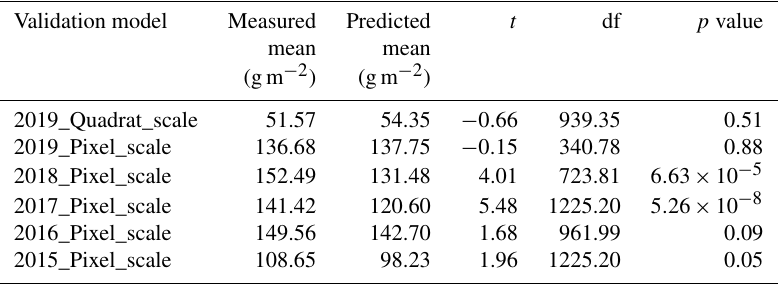
Table 4. T test results between the predicted and measured AGB values for the modes at the quadrat and pixel scales. Note that df means degrees of freedom. Validation model Measured